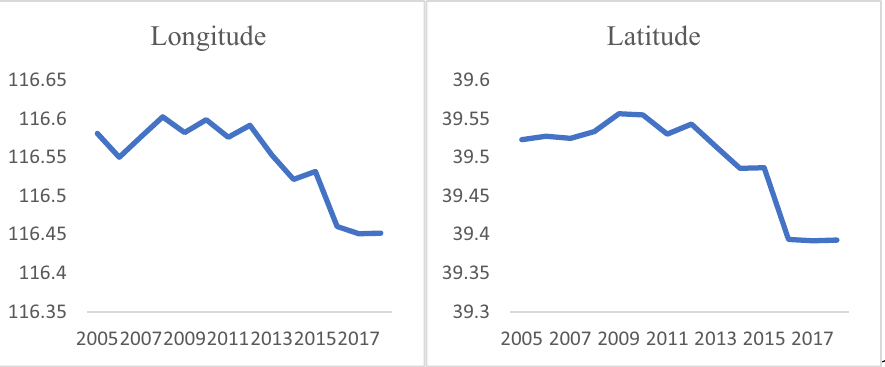
Figure 4. Longitude and latitude changes of population gravity center in BTHUA.